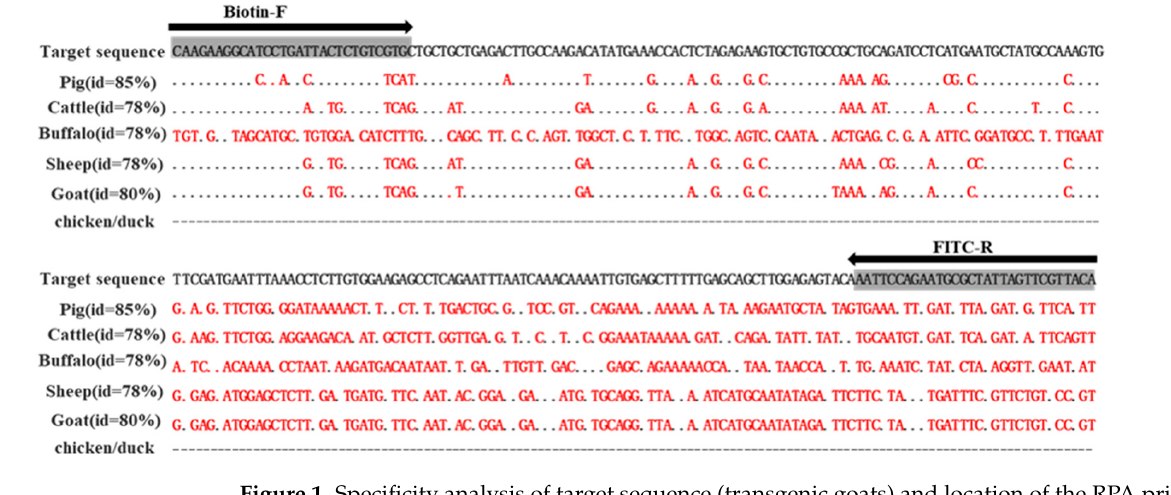
Figure 1. Specificity analysis of target sequence (transgenic goats) and location of the RPA primers. BLAST and ClustalW results of target sequence (transgenic goats) with genomic sequences of other species (non-transgenic): pigs (85%), cattle (78%), buffalos (78%), sheep (78%), goats (80%), chickens, and ducks (0%). Biotin-F: forward primer, FITC-R: reverse primer. Table 1. Oligonucleotide primers for the RPA-LFD assay in this study.